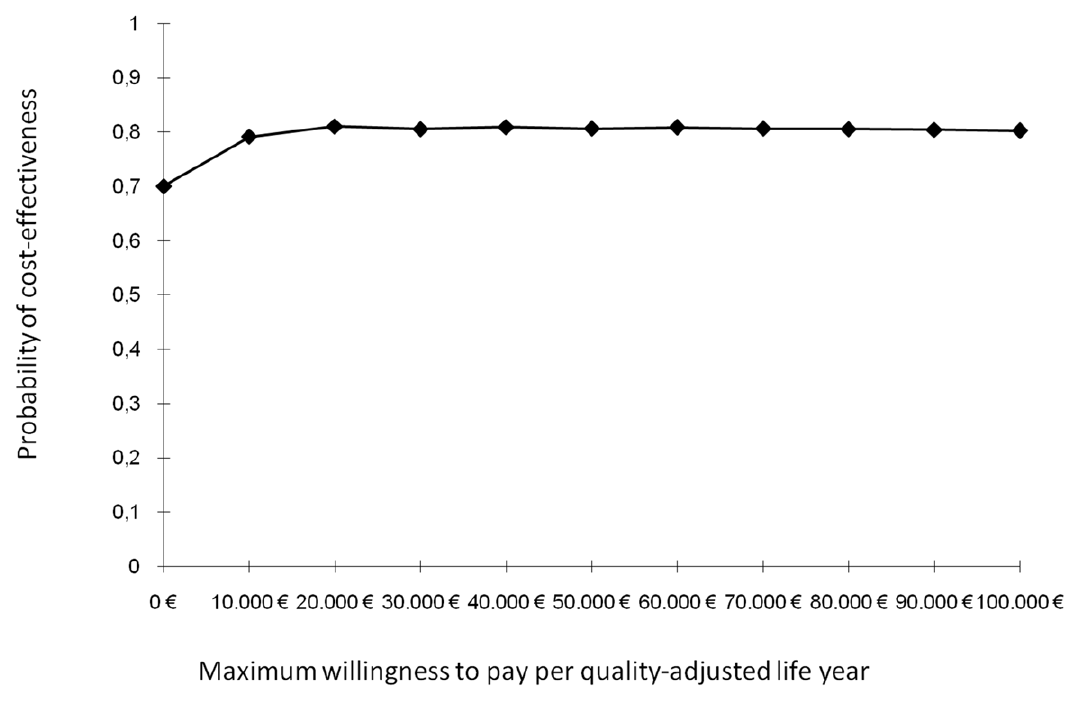
Figure 2. Cost-effectiveness acceptability curve.